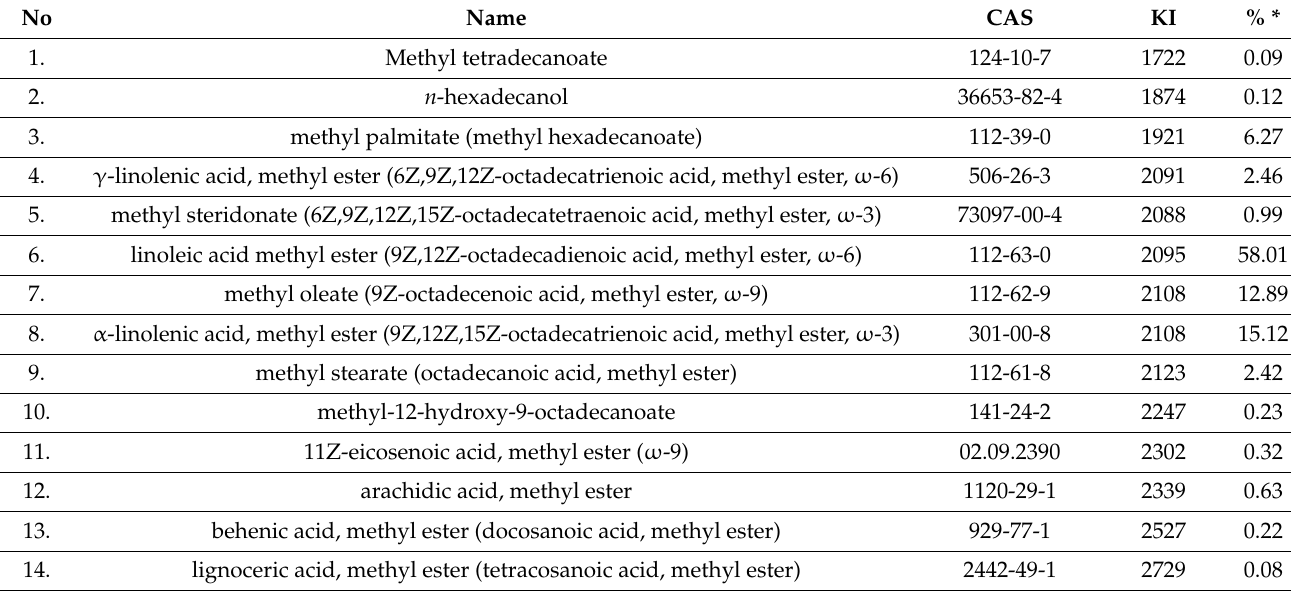
Table 4. GC profile of fatty acids methyl esters of hemp oil.